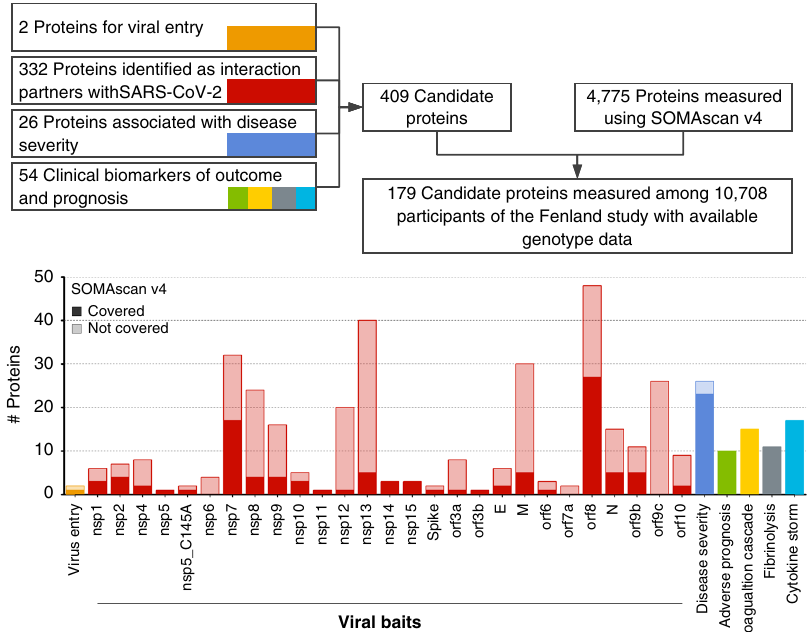
Fig. 1 Flowchart of the identi fi cation of candidate proteins and coverage by the SomaScan v4 platform within the Fenland cohort. More details for each protein targeted are given in Supplementary Data